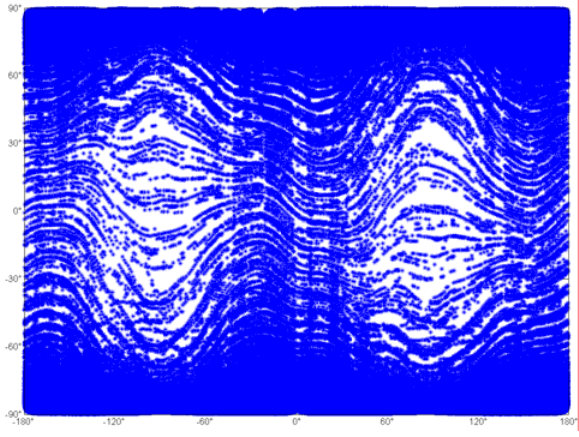
Figure 2. Global distribution of CE-1 LAM crossovers